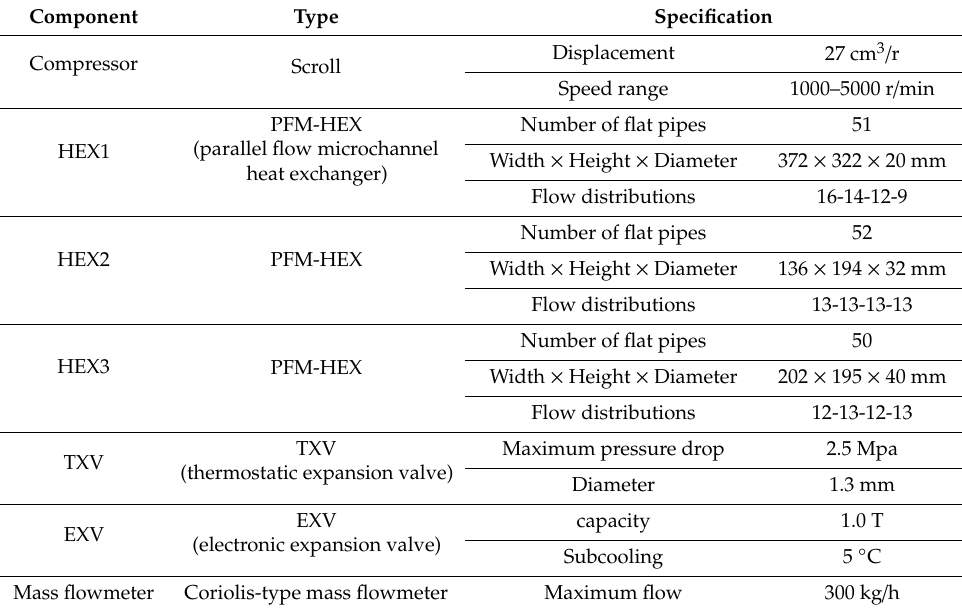
Table 1. Parameters of experiment facility.